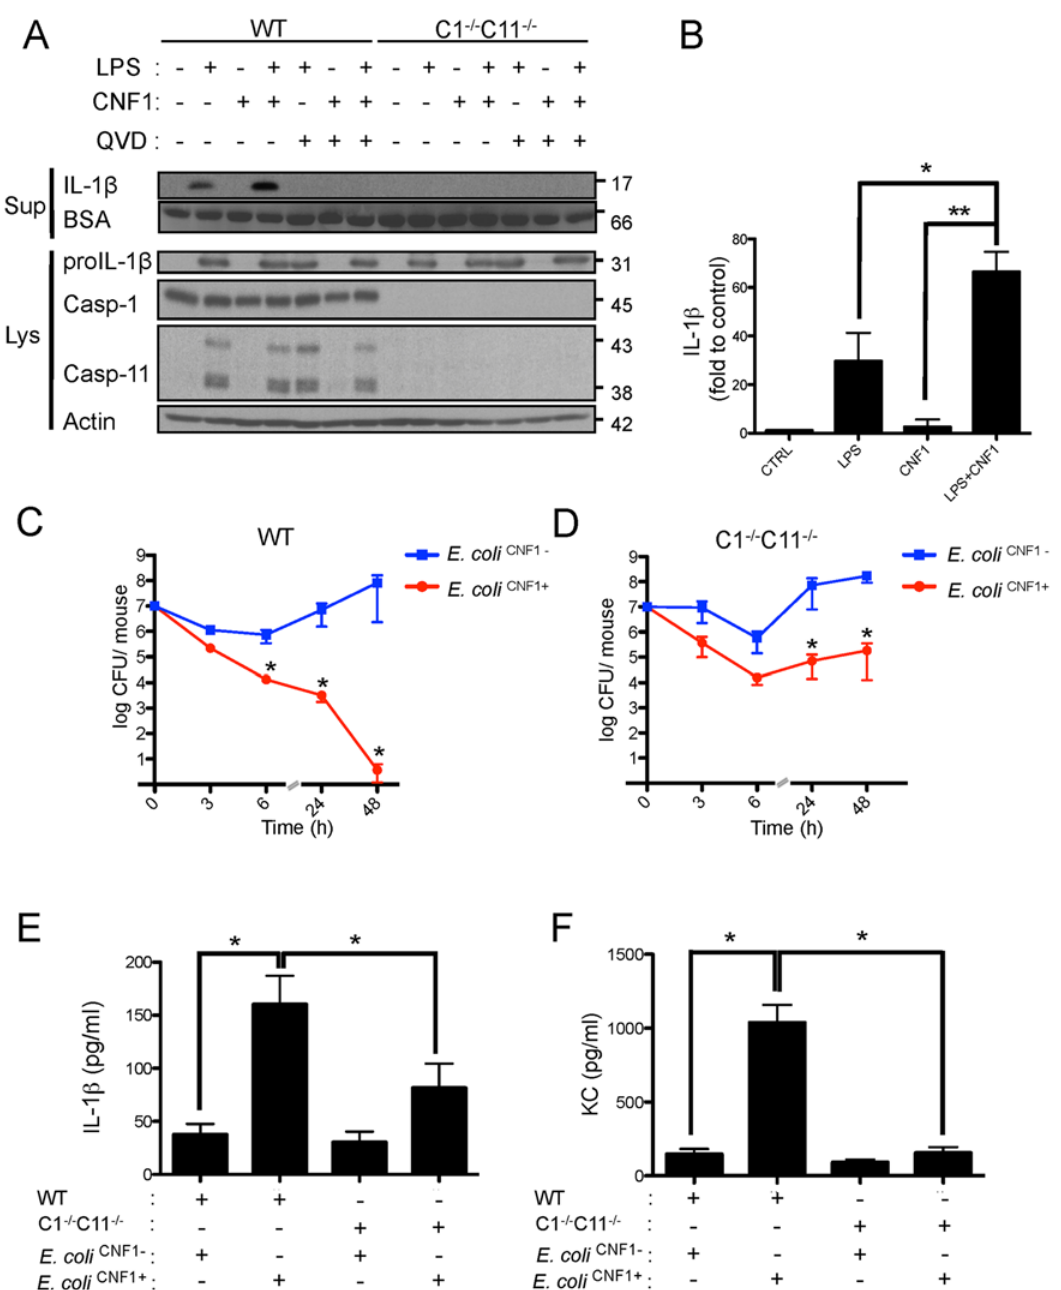
Fig 3. CNF1-triggered immunity requires inflammatory caspases. (A and B) IL-1 β production and maturation/secretion after treatment with CNF1, LPS or CNF1 (1 μ g/ml) + LPS (100 ng/ml) for 10 h. Actin and BSA were used as loading controls. (B) Graph showing the quantification of IL-1 β secretion normalized to the control (n = 3). (C and D) Female C57BL/6 WT (C) or congenic C1 -/- C11 -/- mice (D) were intravenously infected with 10 7 CFUs of E . coli CNF1+ or with the isogenic CNF1-deleted mutant ( E . coli CNF1- ) prior to the collection of peripheral blood at 3, 6, 24 and 48 h for bacteremia measurements. The data are expressed as the mean ± SEM (n = 7 – 8). (E and F) Analysis of the circulating levels of IL-1 β (E) and KC (F) in the mouse sera by ELISA. Serum samples from mice infected with 10 7 E . coli CNF1+ or with the isogenic mutant E . coli CNF1- were collected at 3 h after intravenous infection and analyzed by ELISA (n = 3). P-values < 0.05 ( * ); and P-values < 0.01 ( ** ) were considered statistically significant.